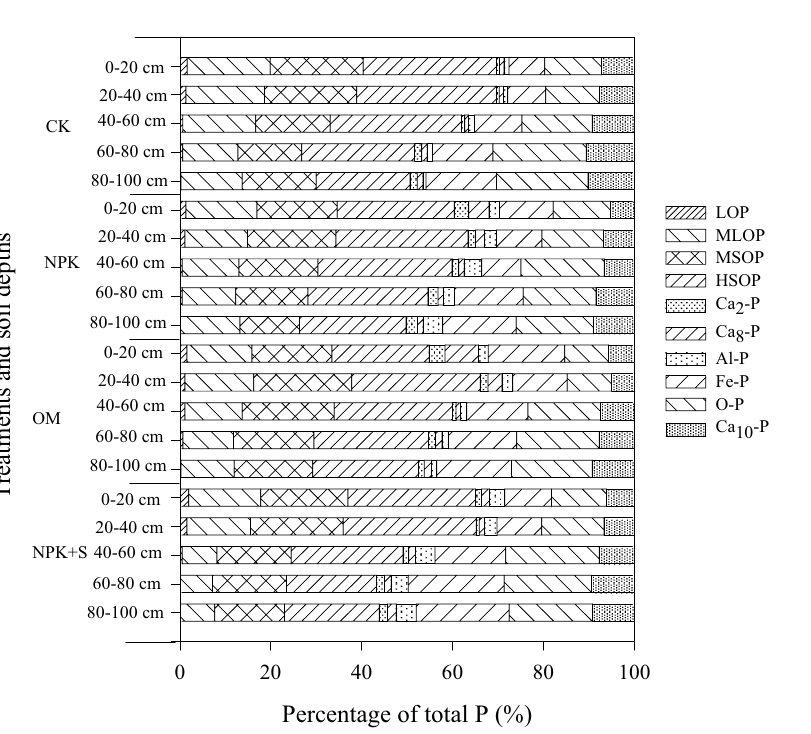
Figure 7. Effect of long-term application of chemical fertilizer, organic manure and straw on the percentage of different P fractions. LOP, labile organic P; MLOP: moderately labile organic P; MSOP: moderately stable organic P; HSOP: highly stable organic P. CK: no fertilizer application, NPK: chemical fertilizer application, NPK + S: chemical fertilizer plus maize straw incorporation, OM: organic manure